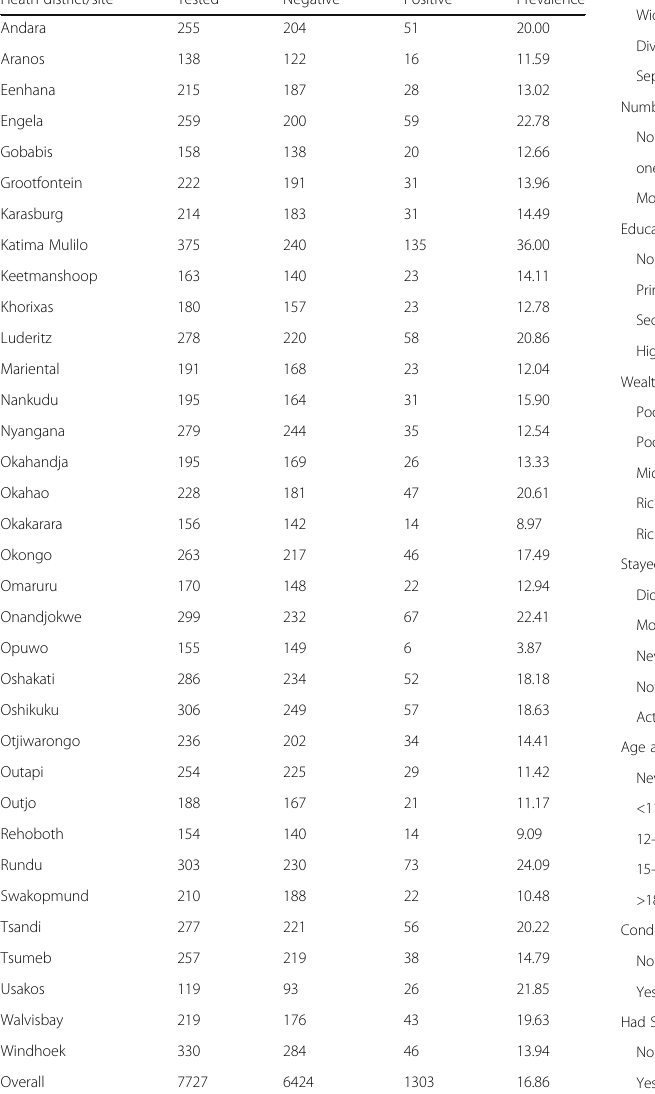
Table 6 Observed HIV prevalence per health district/site Heath district/site